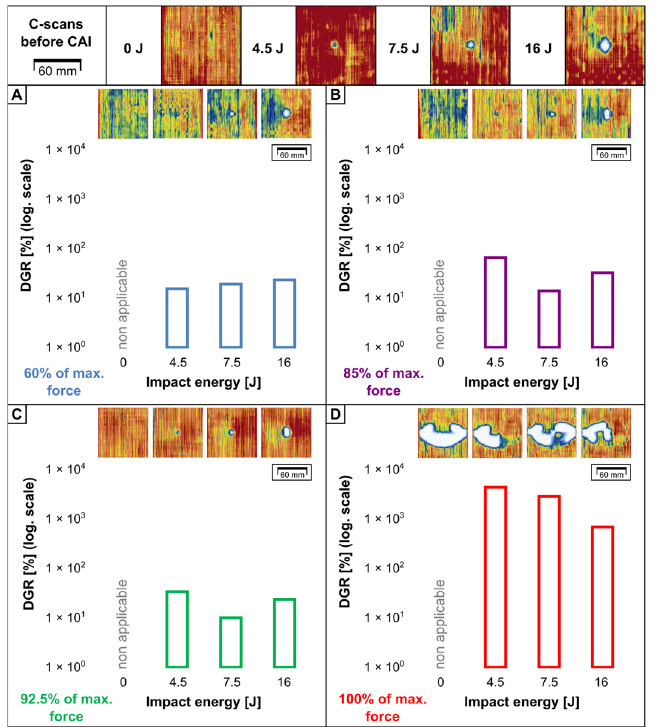
Figure 12. Ultrasonic C-scans of damaged areas in AGL laminates before CAI and after CAI for following force thresholds: 60% ( A ), 85% ( B ), 92.5% ( C ) and maximal force ( D ). The relation of delamination growth ratio to impact energy is also presented.